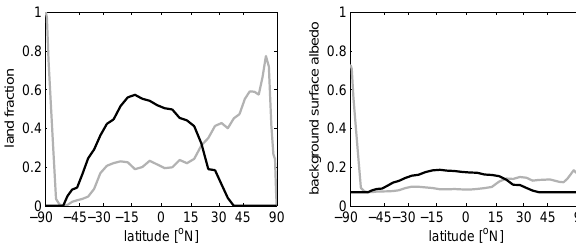
Fig. 2. Zonal-mean land-sea mask (left) and background surface albedo (right) of the Marinoan (black) and present-day (gray) setup. The abscissa is linear in sine of latitude such that the spacing be- tween the latitudes is proportional to the Earth’s surface area be- tween them.